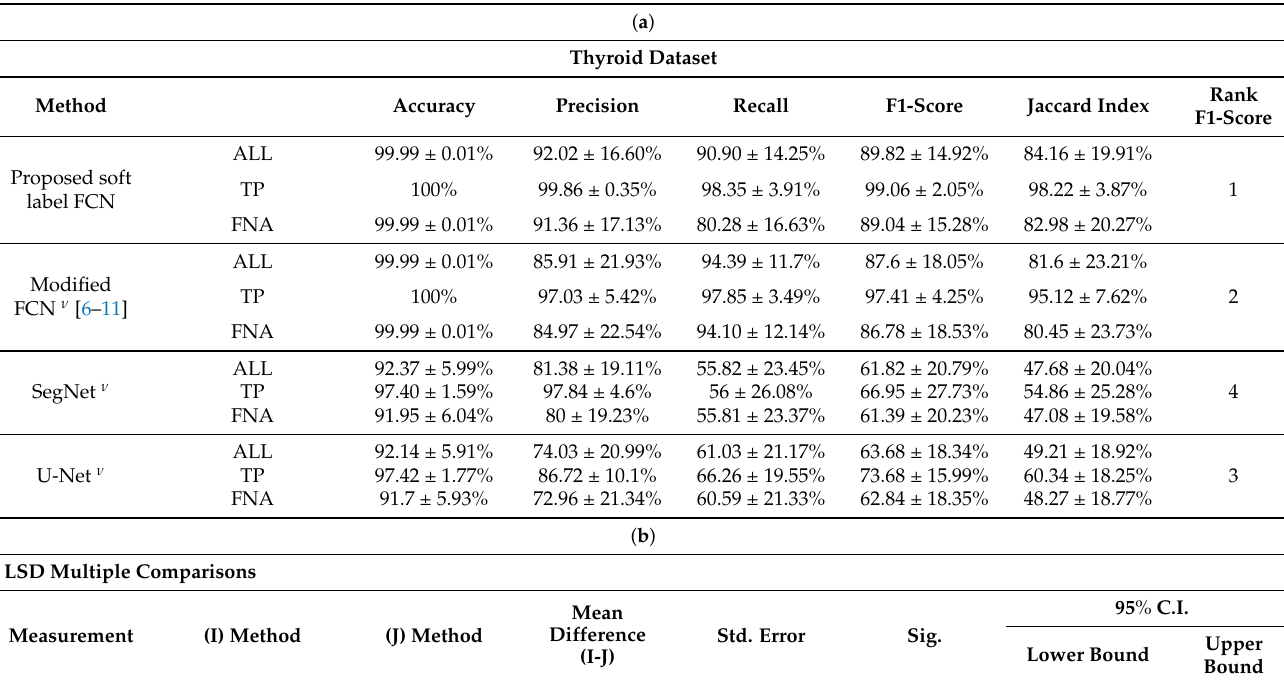
Table 7. Quantitative evaluation with statistical analysis in segmentation of thyroid cancer. ( a ) quan- titative evaluation; ( b ) statistical analysis: LSD test. ( a